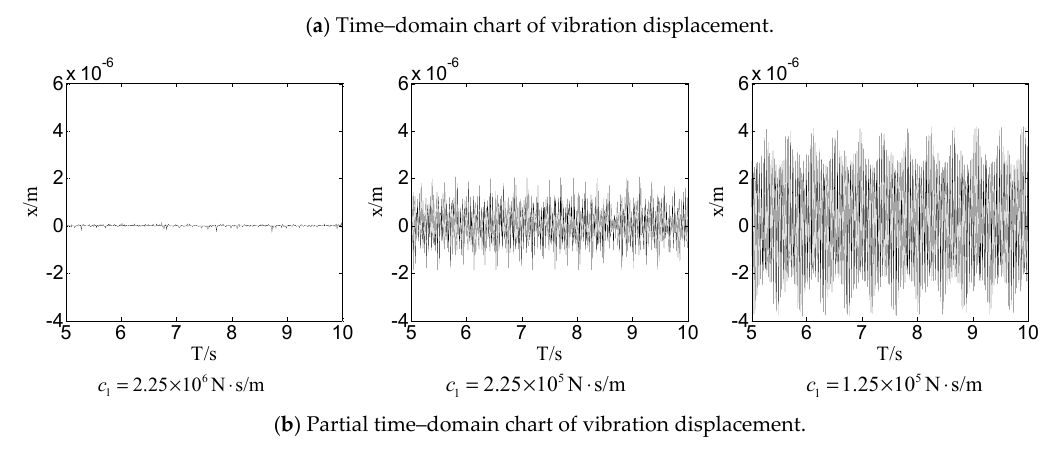
( b ) Partial time–domain chart of vibration displacement.